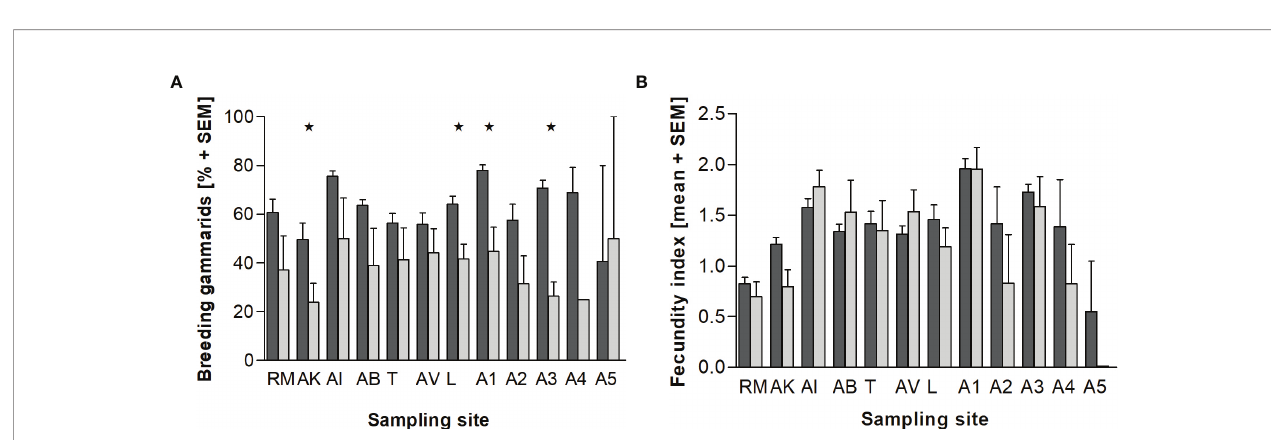
FIGURE 3 | Long-term monitoring in NW-Brittany (2012-2020). Percentage of breeding animals (A) and fecundity index (B) of non-intersex (dark gray) and intersex (light gray) Echinogammarus marinus . Statistically signi fi cant differences between normal and intersex specimens are marked by asterisks (* = p < 0.05; t test). For abbreviations of the sampling sites see Table 1 .